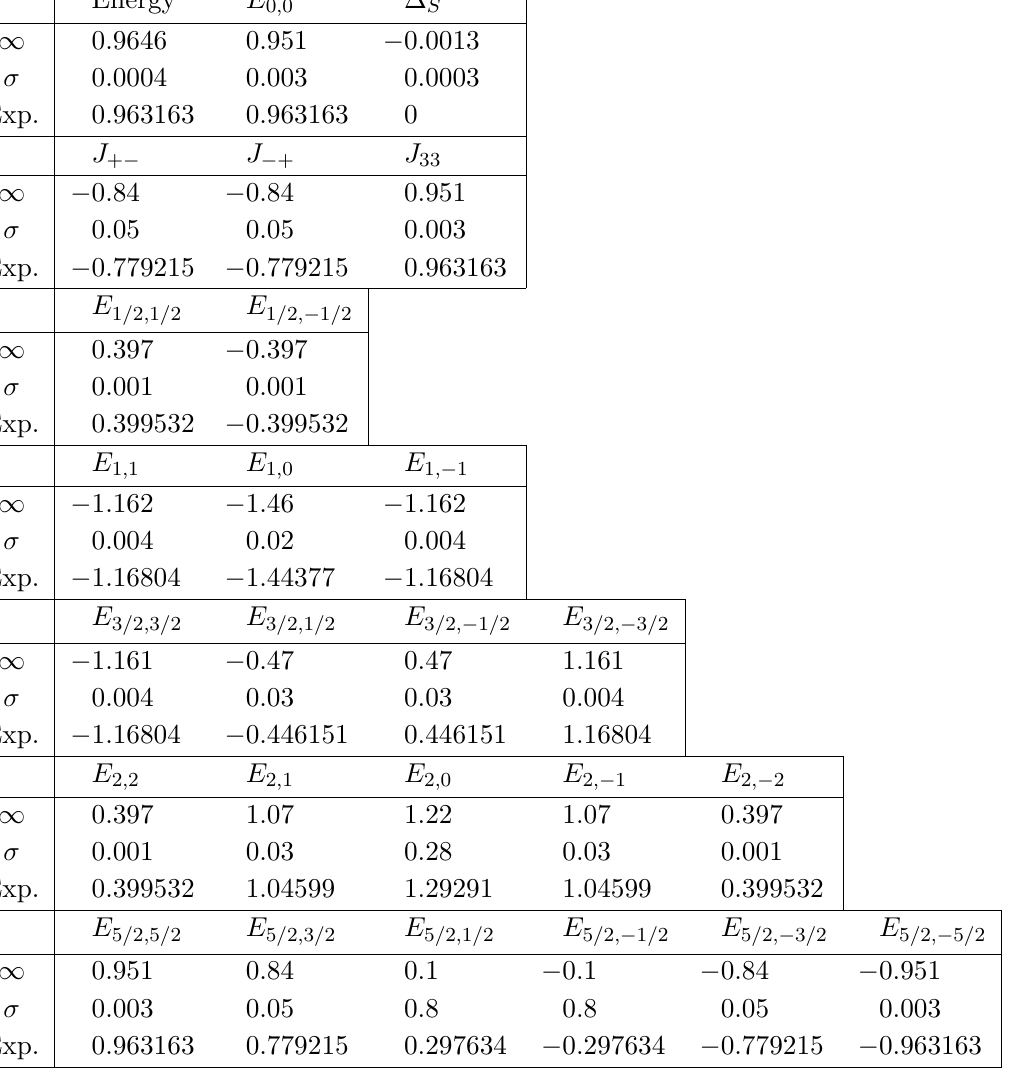
Table 29 . Extrapolations of observables of a solution describing two SU(2) Cardy 0-branes with in the k = 5 model with J = 1 boundary conditions. θ 1 = − θ 2 = 2 π k